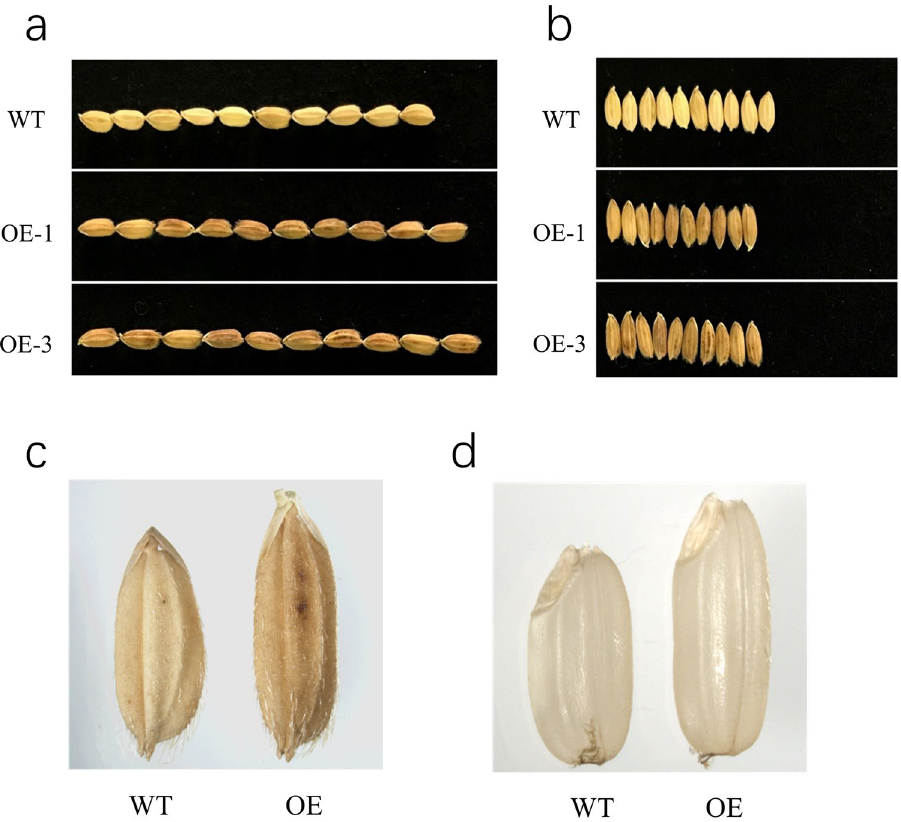
Figure 8. Seed phenotypes of WT and OsSCL30-OE of rice. ( a ) Grain length. ( b ) Grain width. ( c ) Glume color. ( d ) Endosperm color.